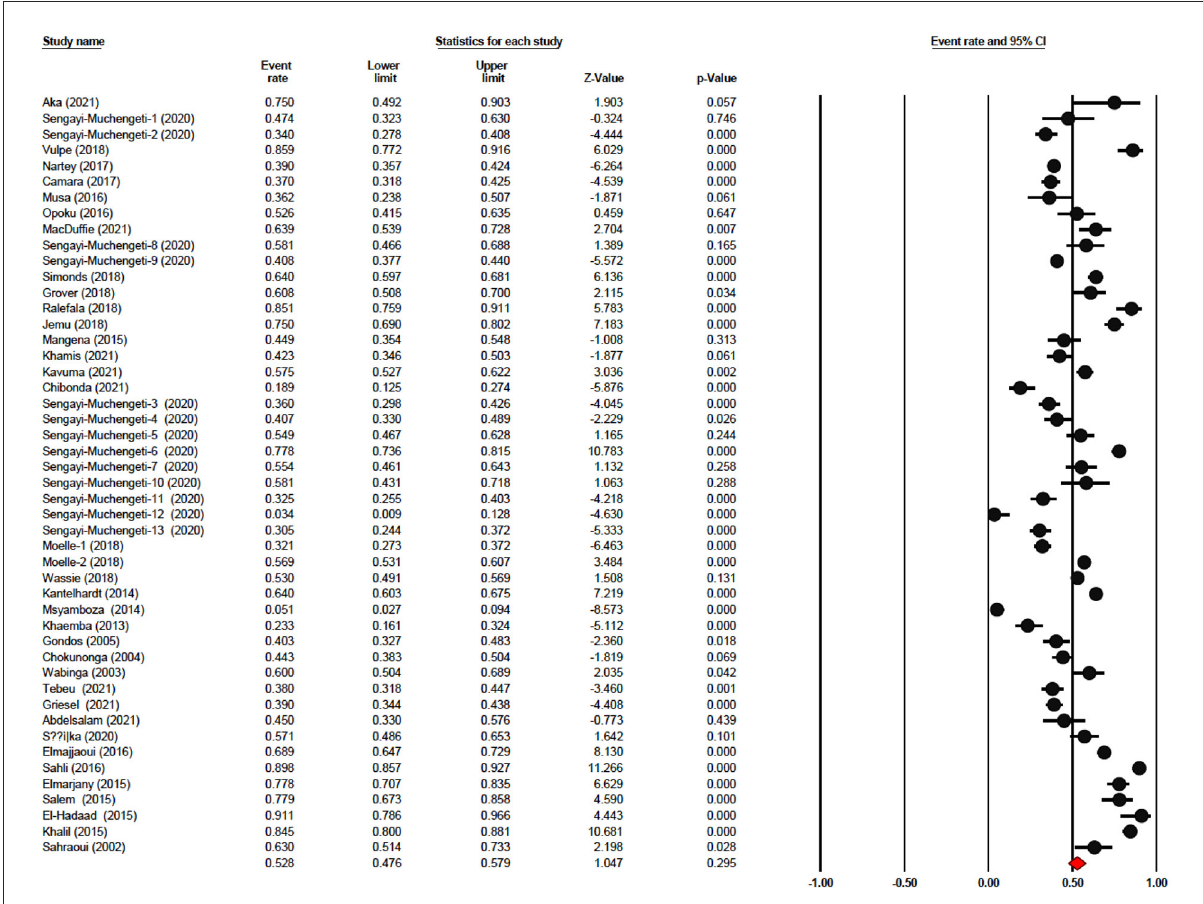
FIGURE2 Forest plot showing the 3-year OS.